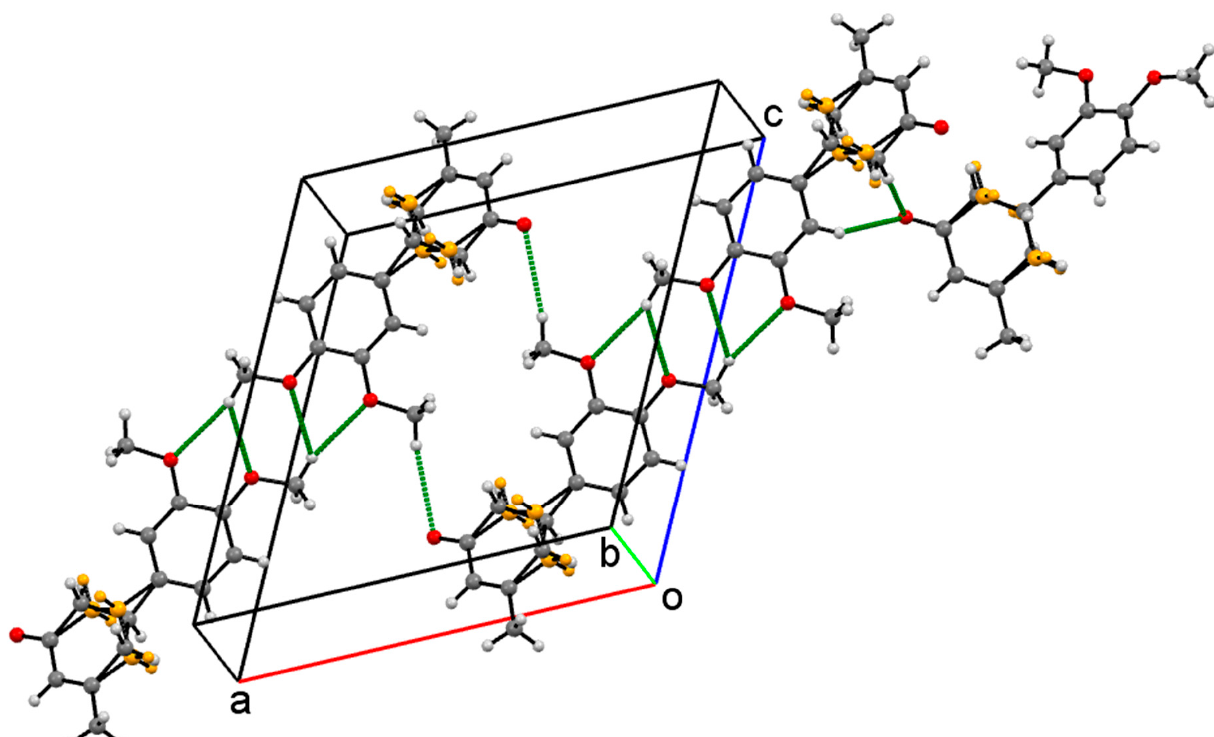
Figure 7. Packing of the crystals of compounds III and short contacts C–H···O (dashed green line).